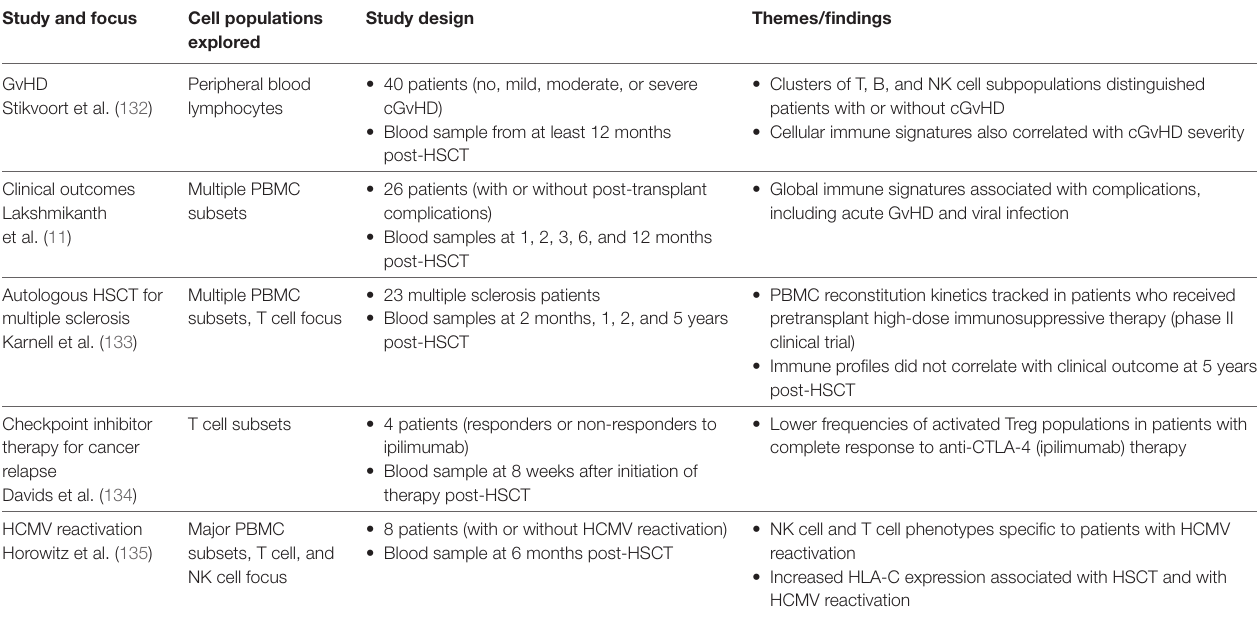
TABLe 2 | Selected studies using mass cytometry to analyze immune reconstitution after